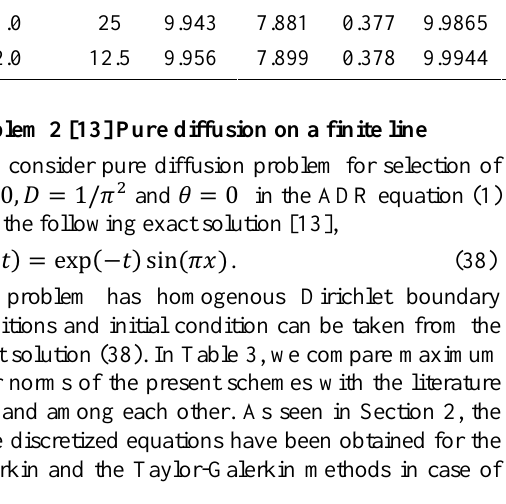
Table 3. Comparison of the error norms produced with various values of the Peclet number and (cid:16)(cid:17) (cid:2) 0 in Problem 2. CN [13] GFEM